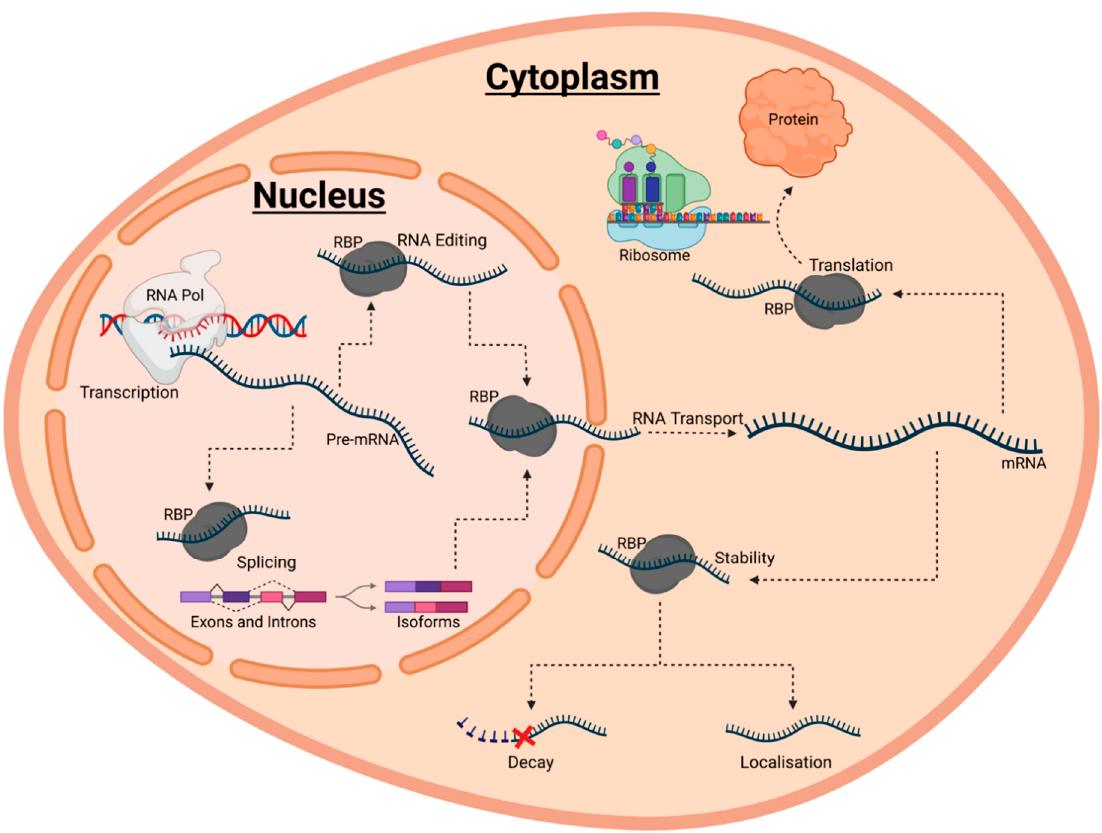
Figure 1. A schematic diagram summarising the various roles of RNA-binding proteins (RBPs) in post-transcriptional gene regulation (PTGR). PTGR encompasses the maturation, transport, stabilit, and translation of coding and non-coding RNAs. Each of these events are heavily regulated by ribonucleoprotein complexes with RBPs at their core. Typically, RBPs are first involved in the maturation of RNA through regulating processes such as RNA editing and splicing. Following this, mature RNA transcripts are exported to the cytoplasm by various RBPs. Within the cytoplasm, RBPs then coordinate the localisation of RNAs to subcellular compartments, as well as orchestrate either the degradation or stabilisation of RNA by binding the substrate RNAs. Stabilisation results in the translation and folding of RNAs into the corresponding proteins constructs.